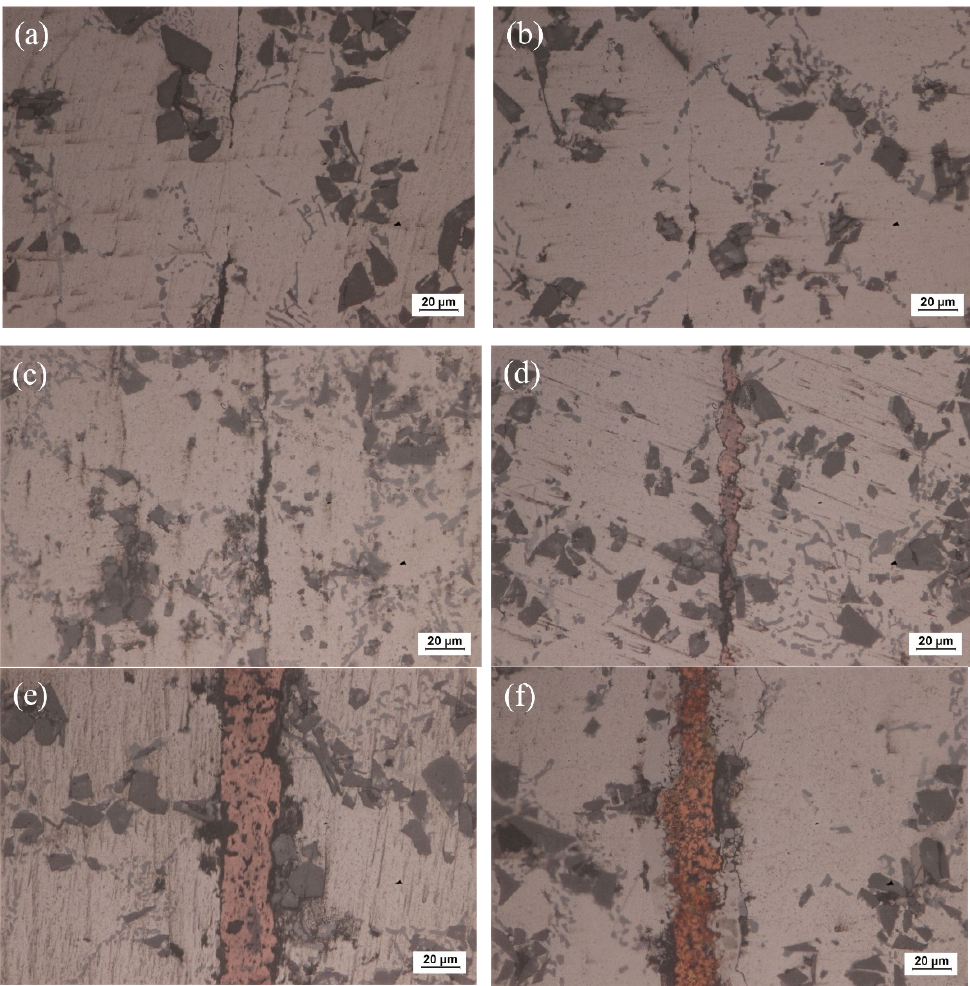
Figure 6. Optical microscope of the joints bonded at: ( a ) 440 °C using liquid Ga; ( b ) 450 °C using liquid Ga; ( c ) 460 °C using liquid Ga; ( d ) 440 °C using Cu NPs and liquid Ga; ( e ) 450 °C using Cu NPs and liquid Ga; ( f ) 460 °C using Cu NPs and liquid Ga.